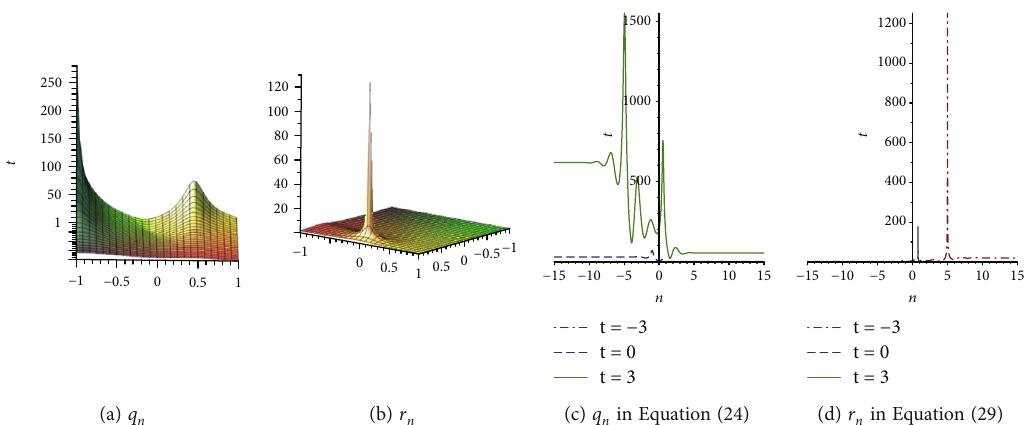
Figure 1: Three-dimensional structure fi gures of explicit solutions from Equation (32) and the evolutions of these solutions with parameters ffiffiffi p λ = 0 : 3 , λ = 0 : 6 I , κ = 3 I , and κ 2 = 1 2 1